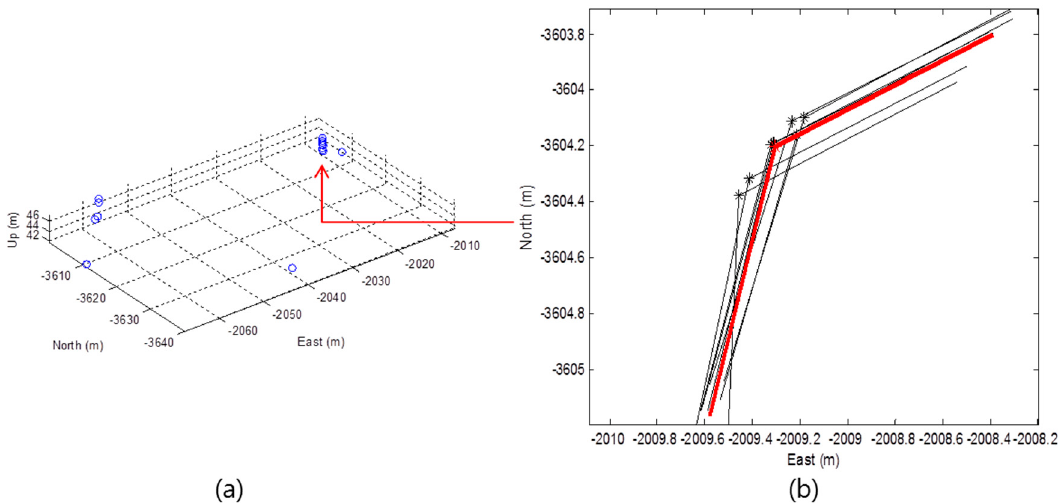
Figure 8. ( a ) 3D position of corner candidates; ( b ) Corner determination result.